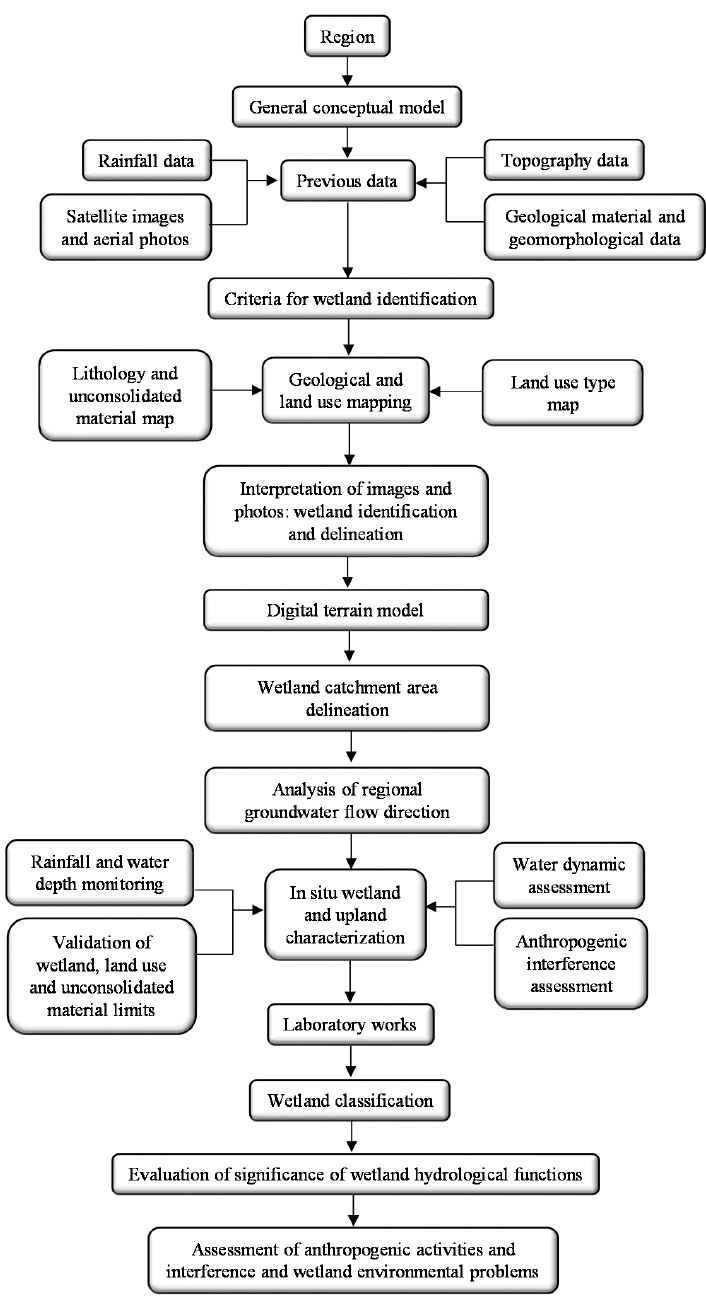
Figure 3. Flowchart of the main steps involved in the study.